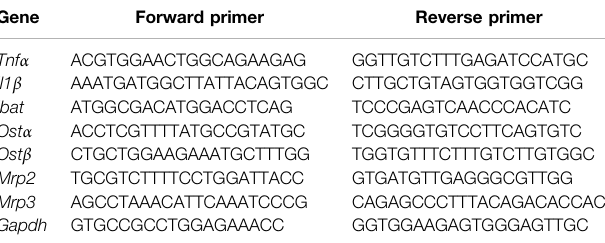
TABLE 1 | Sequences of the primers used for